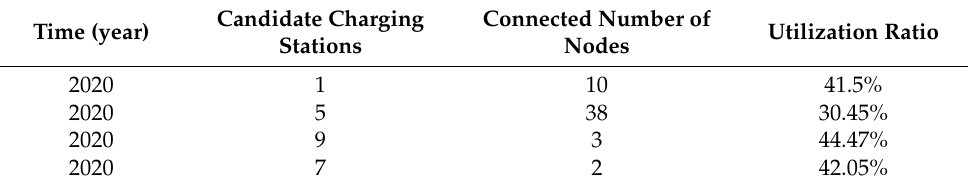
Table 10. Plan for charging stations in